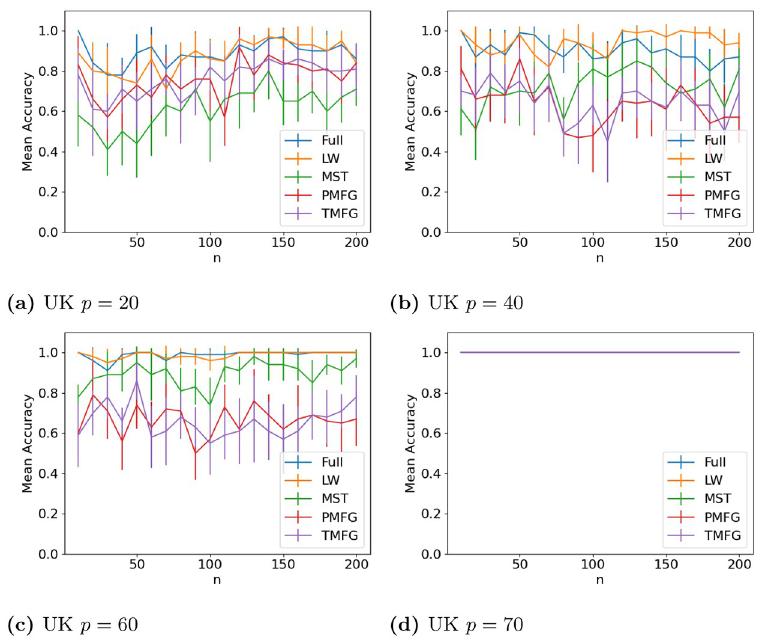
Fig 16. Accuracy when distinguishing between correlation matrices inferred from adjacent time windows based on the median volatility using the SF method and a random forest classifier for UK stock returns. (a) UK p = 20,